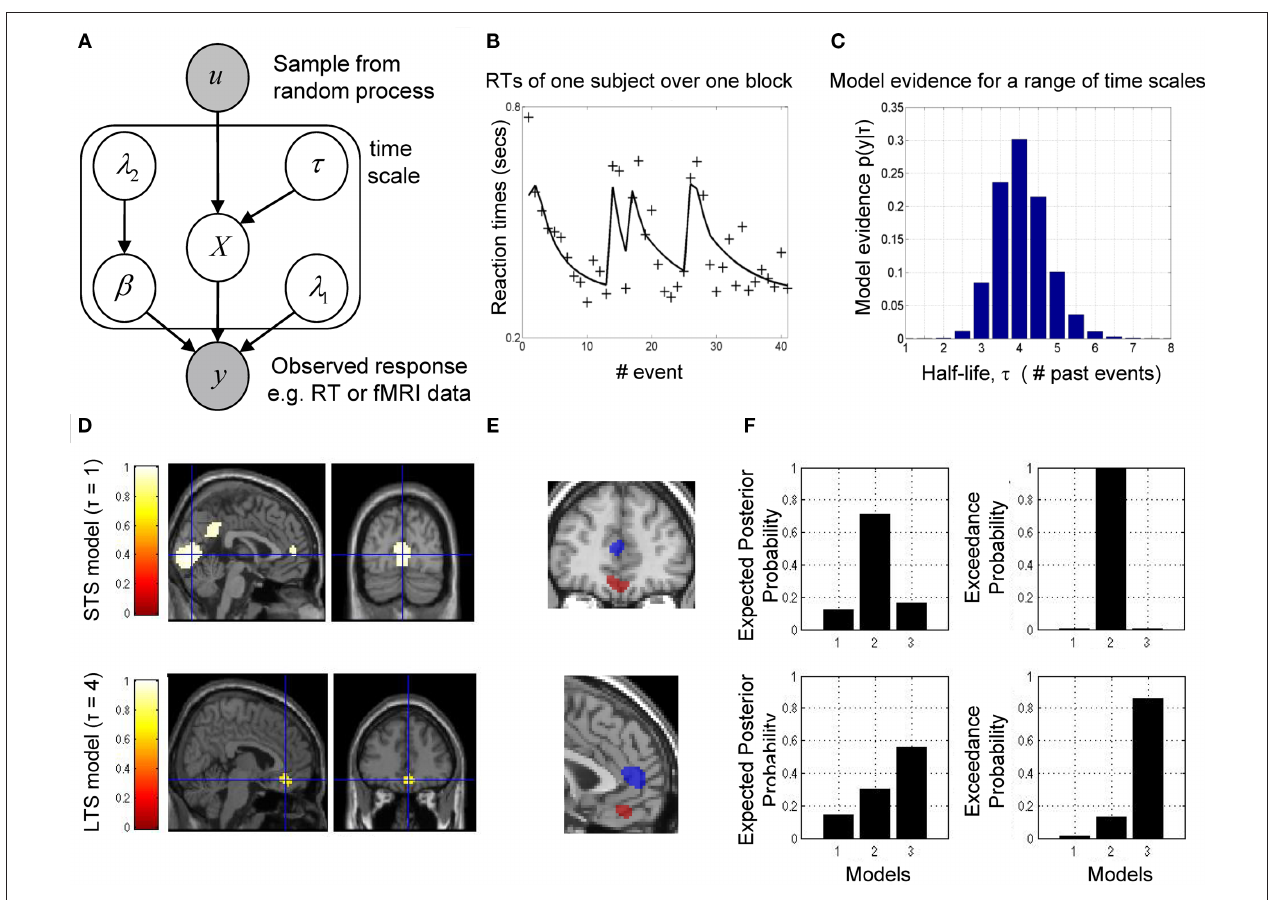
In line with theoretical accounts, evidence for short time scales was predominantly in primary and secondary visual cortex (cross hairs centrered on coordinate [0, − 79, 4] MNI space) and superior parietal cortex. In addition, we found evidence for this in anterior prefrontal cortex (coordinates, [0, 50, 7]), whereas the largest evidence for long time scales was found in orbitofrontal cortex (coordinates, [6, 38, − 14]). Both regions are color coded and shown in greater detail in (e) . (e) Overlay of EPMs for both STS and LTS, illustrating the partitioning of prefrontal cortex according to progressively longer time scales. (F) A histogram of the EPM from the voxel containing the maximal value from both regions in (e) are shown on the far right, along with the expected probability to its